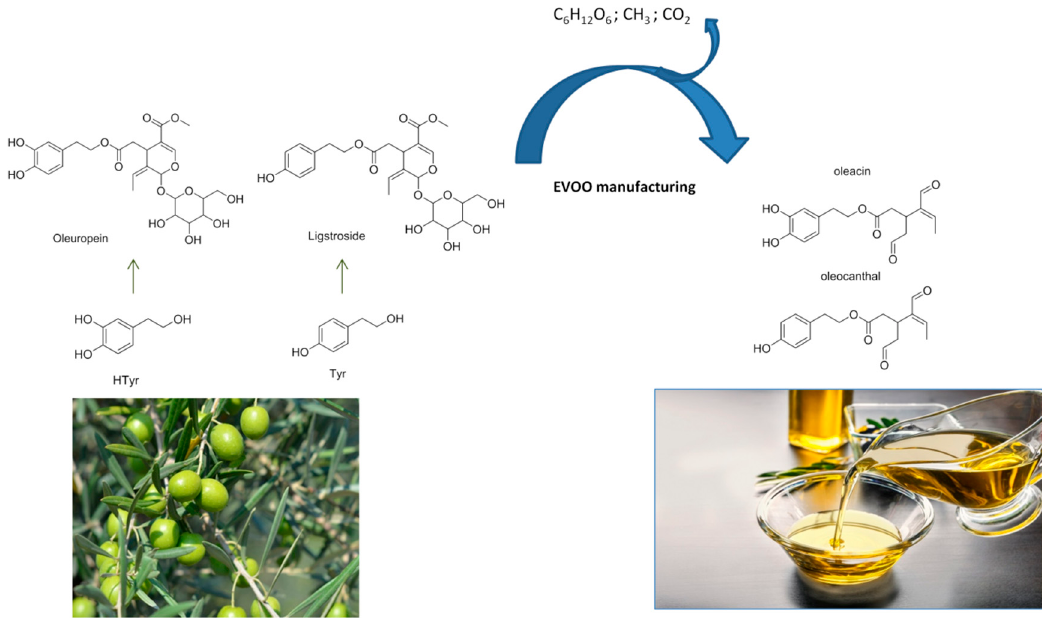
Figure 2. Oleocanthal and oleacein formation. During EVOO manufacturing, secoiridoids (oleuropein and ligstroside) are deglycosylated, and after demethylation and spontaneous decarboxylation free dialdehydes are